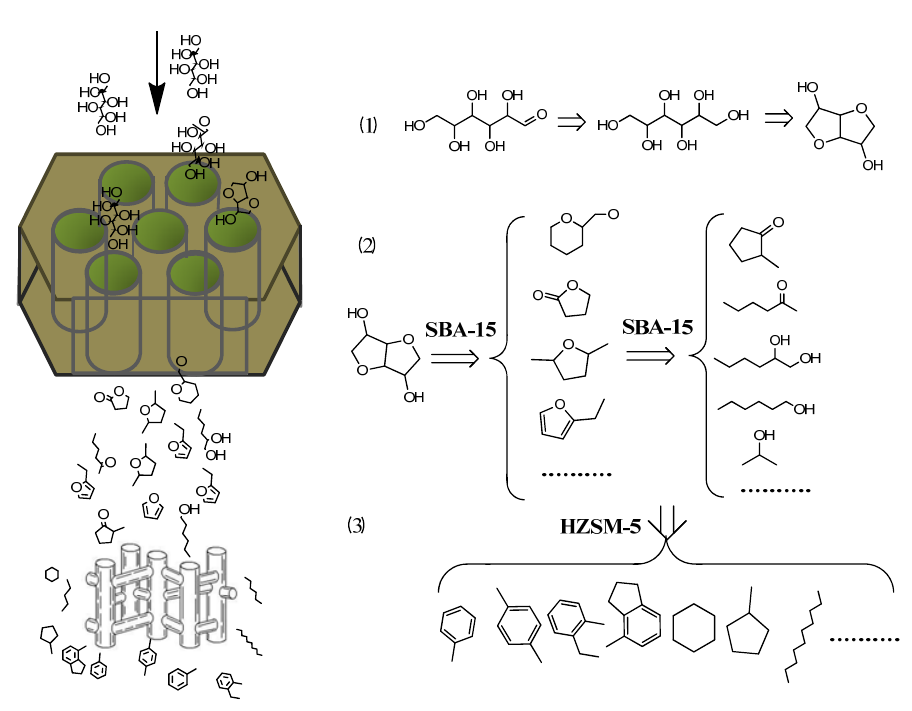
Figure 7. Reaction scheme for biomass-derived sorbitol into liquid